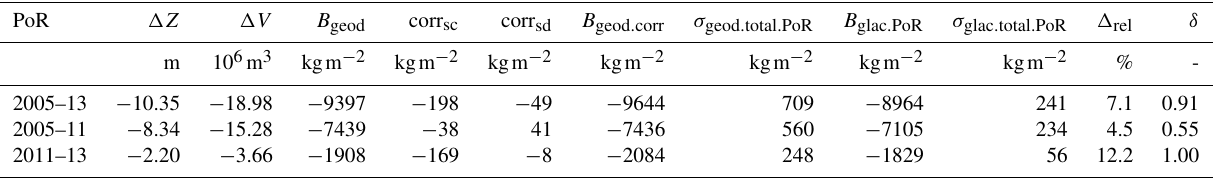
Table 3. Results of the geodetic analyses and the cross-check between glaciological and geodetic method. PoR stands for the observation period, (cid:49)Z is the mean surface elevation change, (cid:49)V the volume change, B geod is the uncorrected geodetic balance assuming a bulk density of 850kgm − 3 , corr sc and corr sd refer to the corrections for snow cover and survey dates, B geod . corr refers to the corrected geodetic balance, σ geod . total . PoR is the total random error of B geod . corr , B glac . PoR is the cumulated glaciological mass balance, σ glac . total . PoR is the corresponding random uncertainty, (cid:49) rel is the relative difference between glaciological and geodetic results and δ is the reduced discrepancy (Zemp et al., 2013).